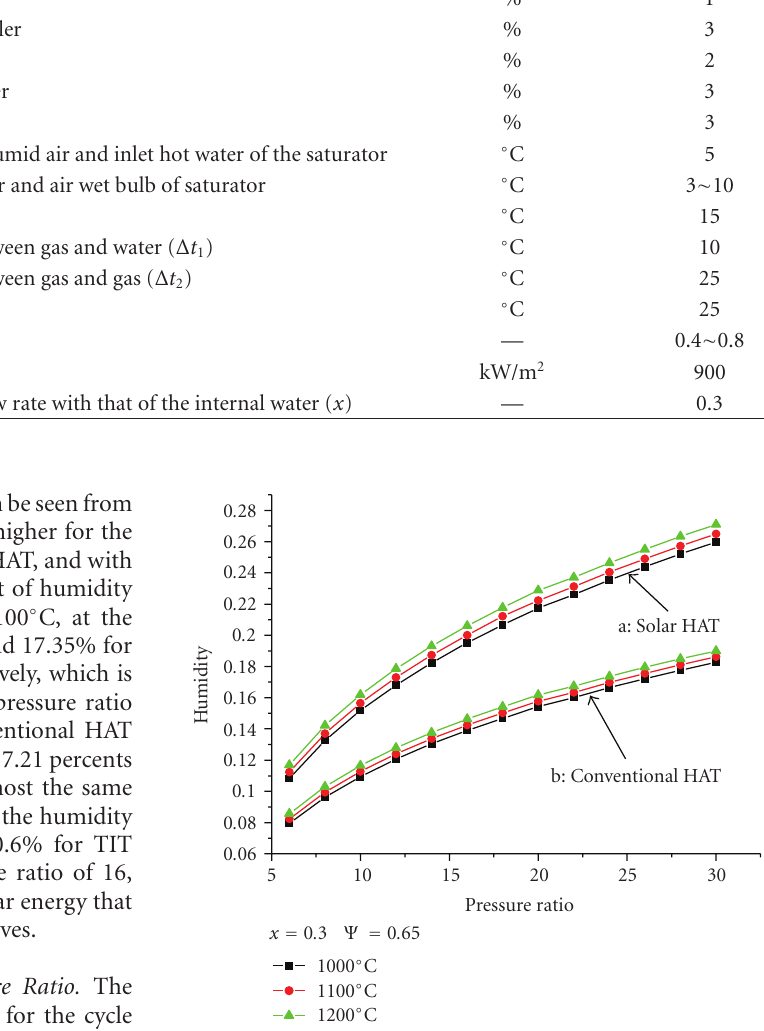
Figure 2: Variation of humidity with pressure ratio.